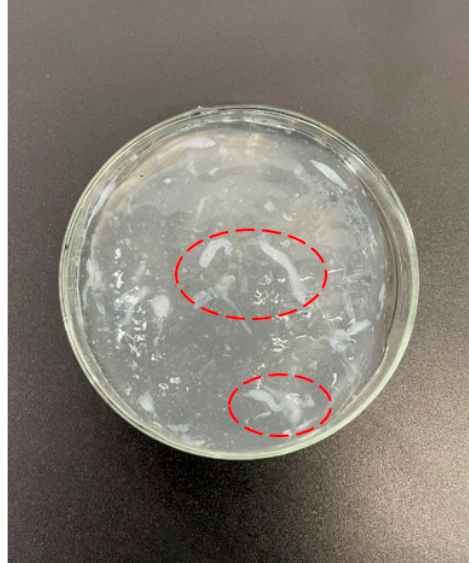
Energies 2022 , 15 , x FOR PEER REVIEW 9 of 17 enabled chelate of 960 Ca 2+ and 528 mg Mg 2+ . Hence, 0.0478 mL CA-5 was required to chelate Ca 2+ and 0.437 mL CA-5 to chelate Mg 2+ in 100 mL of water sample E. The CA-5 chelating agent with a mass concentration of 50 wt.% was used for the optimization ex- periment. Therefore, the mass of the CA-5 solution required to chelate all of the Ca 2+ and Mg 2+ in the 100 mL of water sample E was (0.0478 + 0.437)/50% = 0.9696 g. To facilitate subsequent experiments, the dosage of the CA-5 chelating agent in water sample E was determined to be 1 wt.%. The experimental steps of the chelating agent dosage optimization were as follows: add the same amount of water sample E into four beakers, followed by unequal dosage of CA-5 chelating agents with a mass concentration of 50 wt.%, forming systems with concentrations of 0.6 wt.%, 0.8 wt.%, 1.0 wt.%, and 1.2 wt.%, respectively. Under high- speed stirring, slowly add JK101 to four beakers and stir continuously for 15 min to form guar gum base fluid with a mass concentration of 0.45 wt.%. Finally, add equal dosages of the YC-150 regulator and YZ-1 crosslinker to the four guar gum base fluids to observe their crosslinking performance. The experimental results showed that the crosslinked gel fracturing fluids in the four beakers had different degrees of crosslinking effect. Among them, the first two groups (i.e., chelating agent concentrations of 0.6 and 0.8 wt.%) showed undesired crosslinking effects. This was mainly because in the process of adding the YC- 150 regulator, the excess Ca 2+ and Mg 2+ in the base fluid reacted with hydroxide to form a white flocculent precipitate (Figure 4), which had a harmful effect on the subsequent crosslinking agent. Although there was a significant increase in viscosity, the formed gel